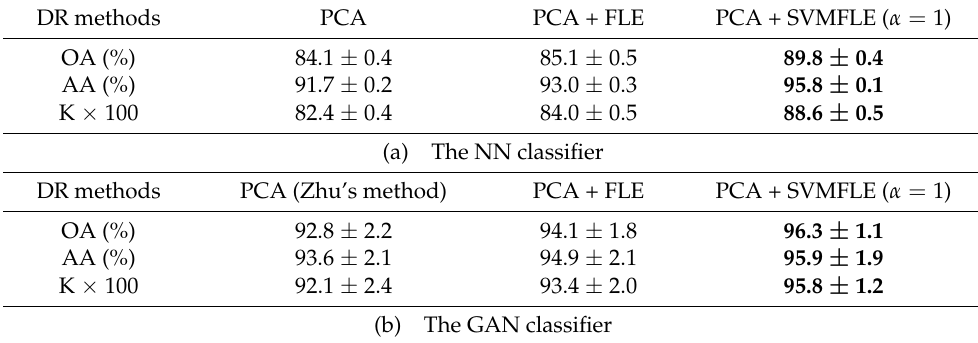
Table 4. The classification results of various DR methods on dataset